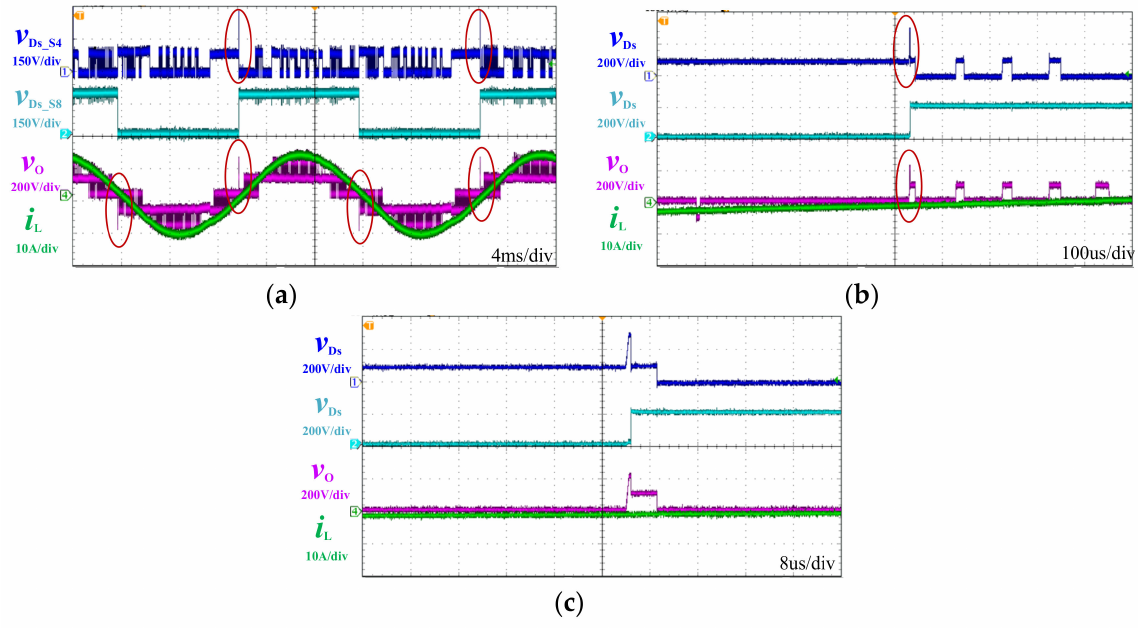
Figure 17. The overvoltage stress issue. ( a ) Under fundamental frequency. ( b ) Under multiple switching cycles. ( c ) Under single switching